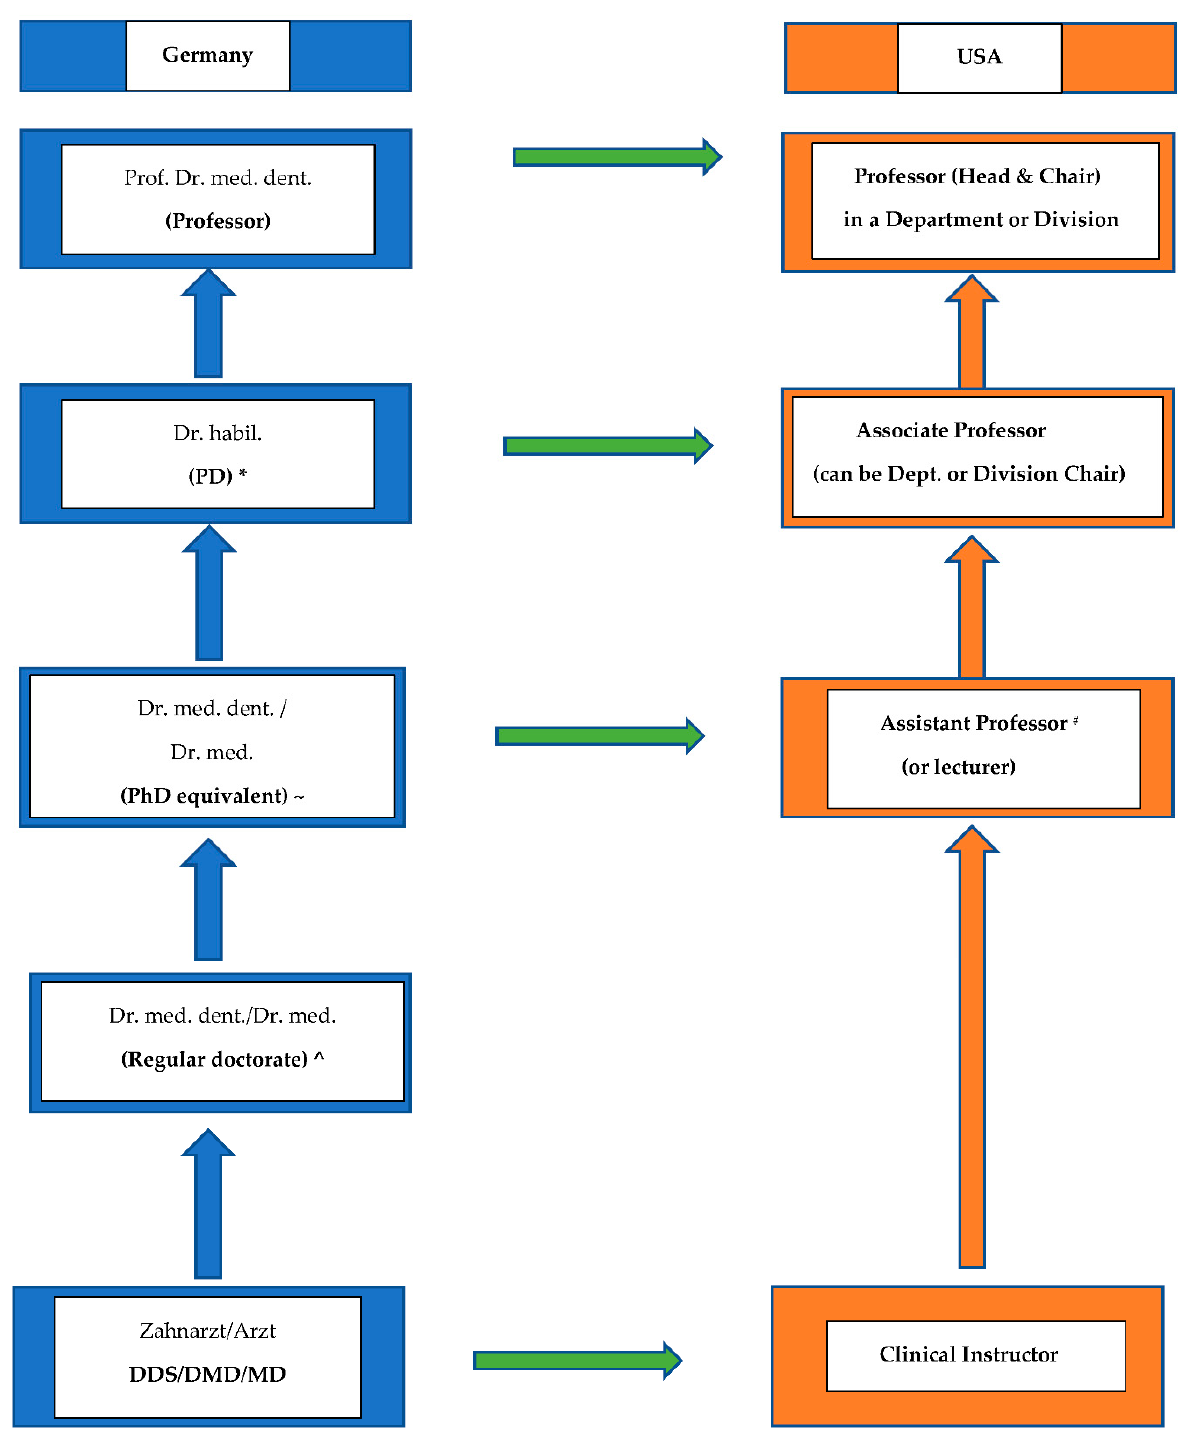
Figure 1. German Dental and Medical Academic Rankings in relationship to the U.S. system. ^ mostly focused on clinical career, can pursue academic or clinical career (lower scientific value, lower grades (rite/cum laude)); ~ preferred doctorate type due to the possibility for higher grades (magna/summa cum laude); * PD—Privatdozent, only in case of affiliation and teaching within the university; # might be the senior lecturer/Assistant Professor (“Oberarzt”) and must have the doctoral (Dr. med. dent.) but not necessarily the postdoctoral degree (so-called “Habilitation”).